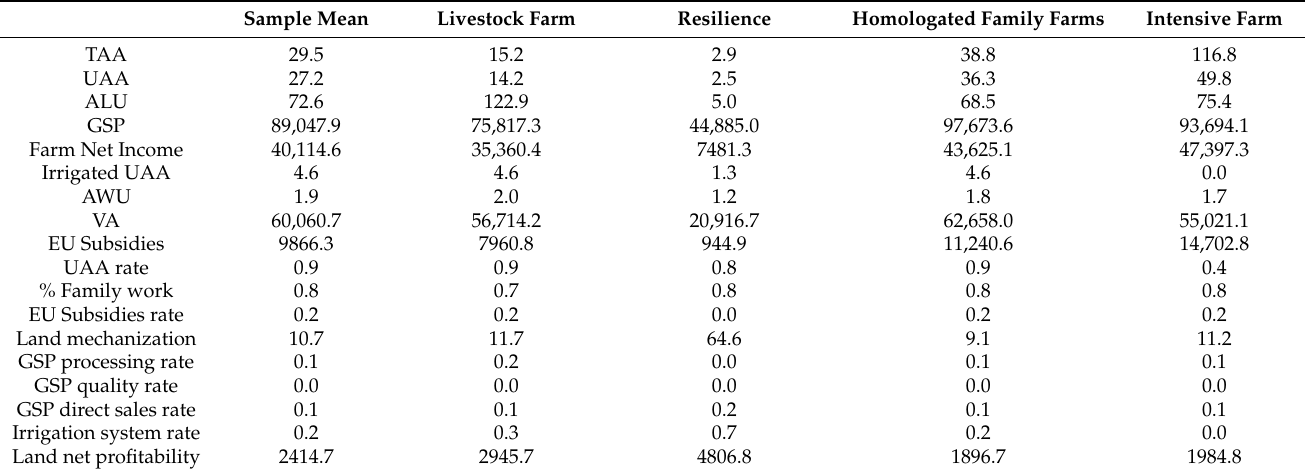
Table A4. Description of the average values of the main structural variables and of the main indexes by cluster identified in the southern geographical breakdown (2020).